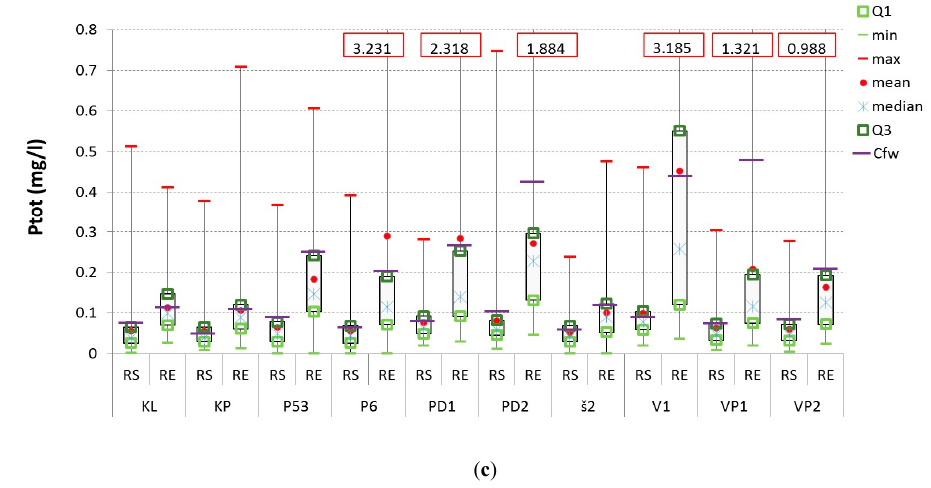
Figure 4. (a) Basic statistics of N-NO 3 concentrations in drainage waters across all the monitored sites, for regular (RS) and event (RE) sampling schemes. Cfw is flow-weighed concentration; ( b ) Basic statistics of P-PO 4 concentrations in drainage waters across all the monitored sites, for regular (RS) and event (RE) sampling schemes. Cfw is flow-weighed concentration; ( c ) Basic statistics of Ptot concentrations in drainage waters across all the monitored sites, for regular (RS) and event (RE) sampling schemes. Cfw is flow-weighed concentration.